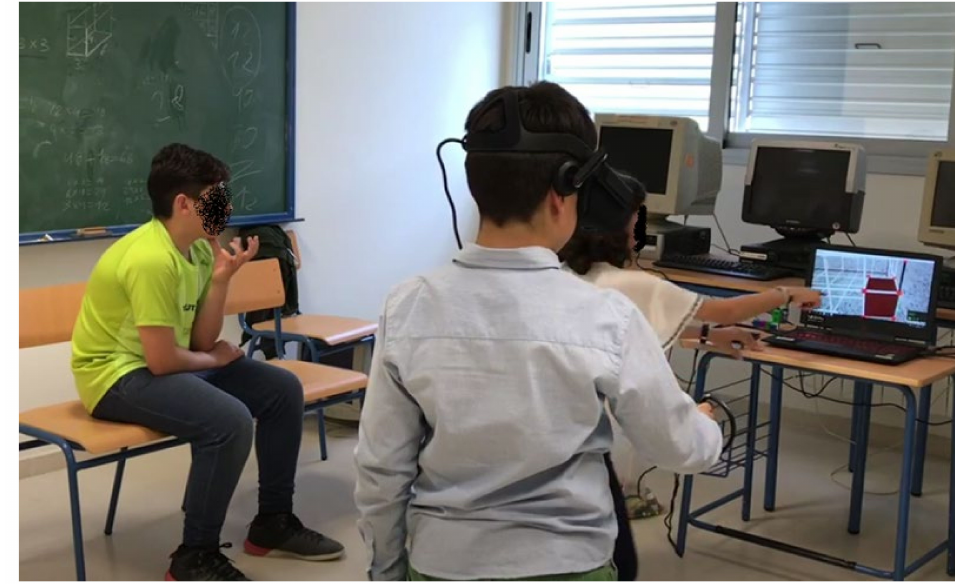
Figure 12. Example of students observing and producing